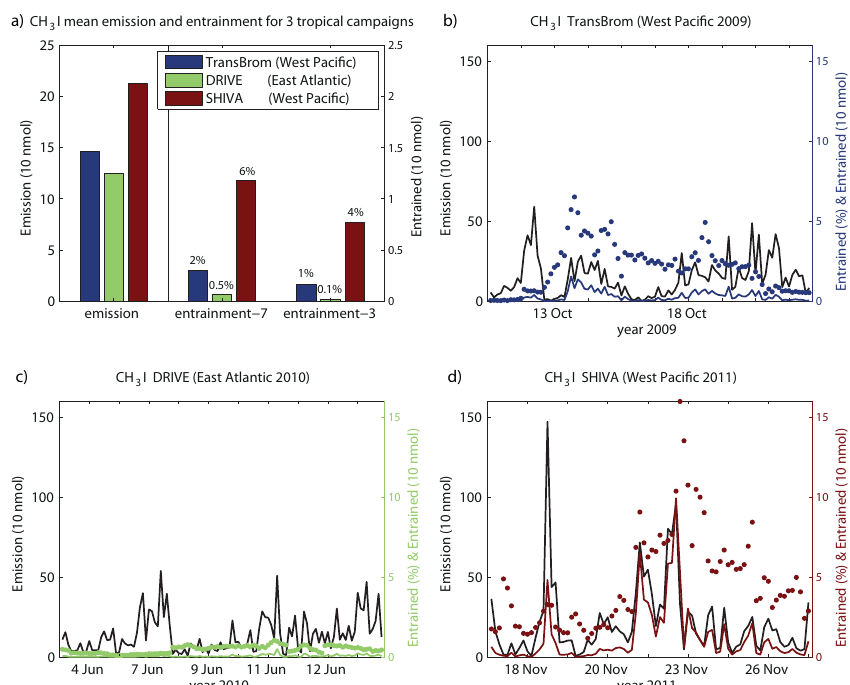
Fig. 3. Campaign-averaged CH 3 I emissions and modeled entrainment above 17km are shown for three tropical campaigns (a) . CH 3 I emis- sions (black line) as well as the relative (colored dots) and total (colored line) amount of CH 3 I entrained above 17km are displayed as a function of time along the cruise track for TransBrom (b) , DRIVE (c) , and SHIVA (d) . Emissions are calculated from the observed flux for a time period of one hour and an area of 500m 2 for each observation. CH 3 I lifetime is prescribed with 7 days (entrainment-7 in panel a and all results in b–d ) or with 2–3 days (entrainment-3 in a